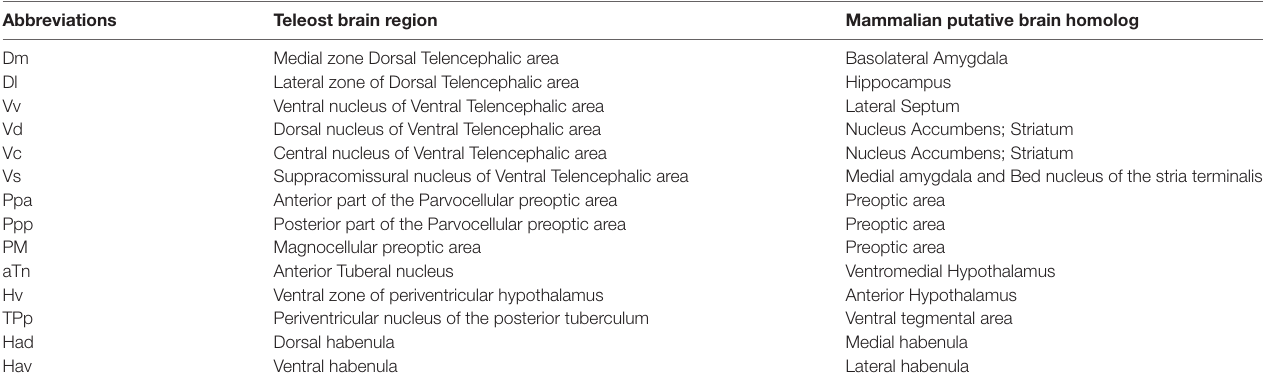
TABLE 1 | Summary of abbreviations of the teleost brain areas analyzed, with the corresponding putative homologies with the mammalian